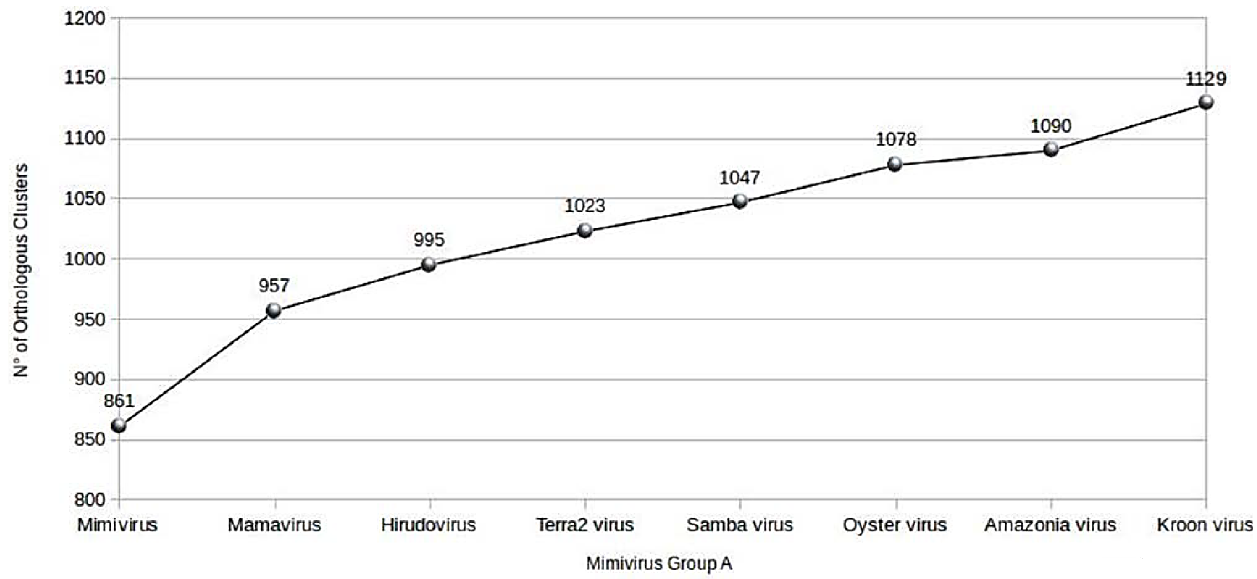
Figure 5. Evolution of the pan-genome size of amoebal mimiviruses of lineage A.